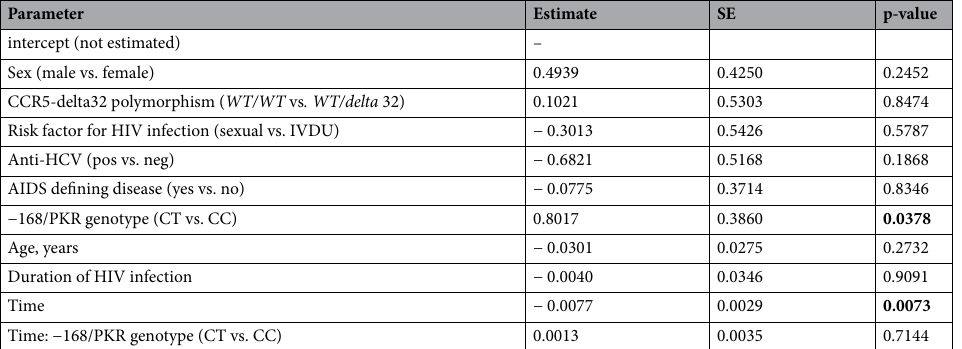
Table 3. Estimated latent class mixed model for CD8 (square root transformed) with one latent class. The term “time: −168/PKR genotype” indicates the parameter for the interaction term, allowing to describe the progression of CD8 for each −168/PKR allelic variant. WT/WT wild type, anti-HCV hepatitis C virus antibodies, AIDS acquired immune deficiency syndrome, PKR protein kinase R. Significant coefficients are in